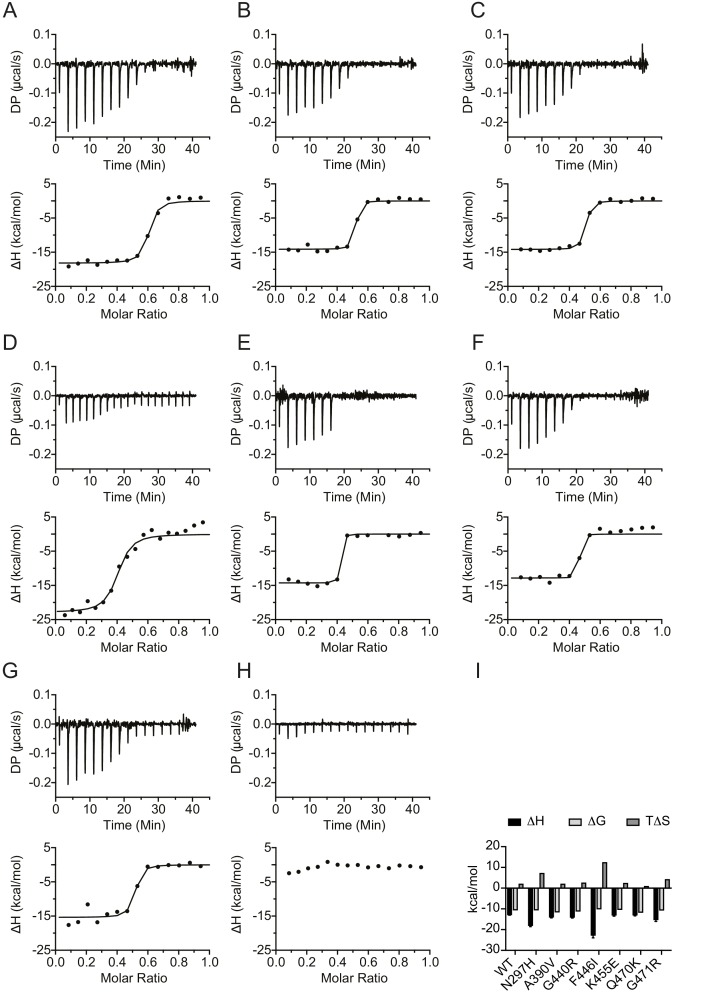
Representative ITC traces of IgG Fc titration against each PRYSPRY variant.(A) N297H. (B) A390V. (C) G440R. (D) F446I. (E) K455E. (F) Q470K. (G) G471R. (H) Buffer control. (I) Binding signature plot. In most experiments, 40 µM of IgG Fc was titrated against 8 µM of PRYSPRY except for the F446I (D) where the concentrations were halved. Data provided in Figure 3—source data 1.